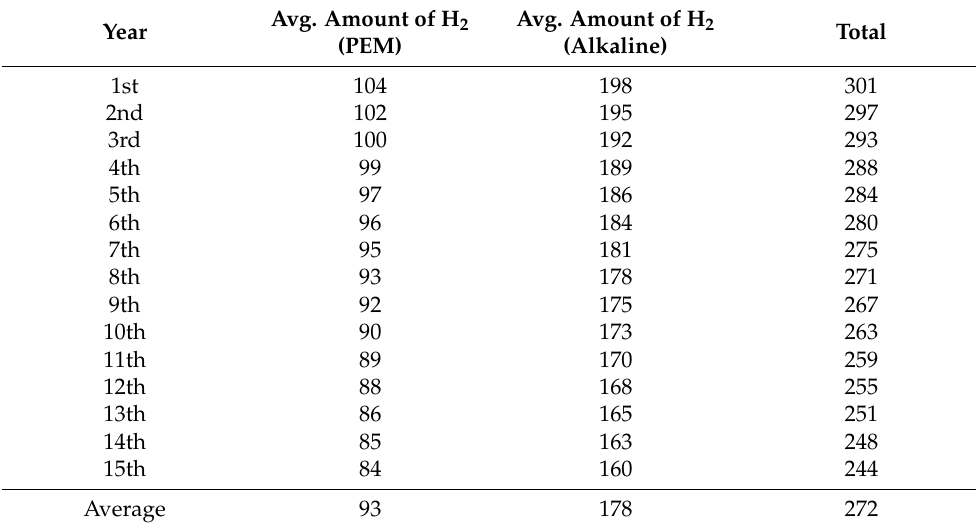
Table 19. The average daily amount of hydrogen produced for each year (Scenario II).